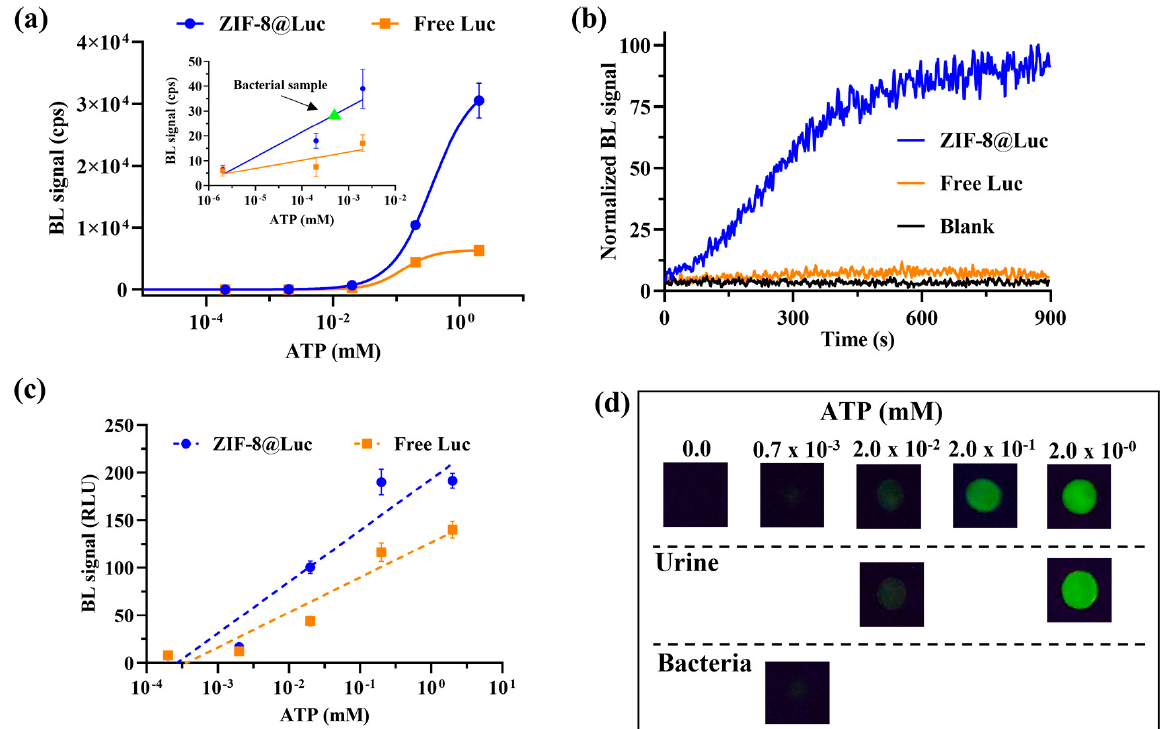
Figure 4. ( a ) Dose–response curve for ATP acquired by LuminoSiPM. The inset represents the linear correlation in the lower range of the BL signal vs. log (ATP conc.) and the points represent the BL average from 3 replicates; ( b ) BL kinetics with LuminoSiPM detection ATP conc. 1 µM; ( c ) dose– response curves for ATP obtained with the smartphone; ( d ) representative images of ZIF-8@Luc paper sensor response in the presence of different ATP concentrations and real samples obtained with the smartphone. * The average of four independent replicates is represented in both graphs. The green triangle corresponds with the concentration of the analyzed bacterial lysate sample. A few error bars (Figure 4a,c) are not visible because they are smaller than the symbol size.